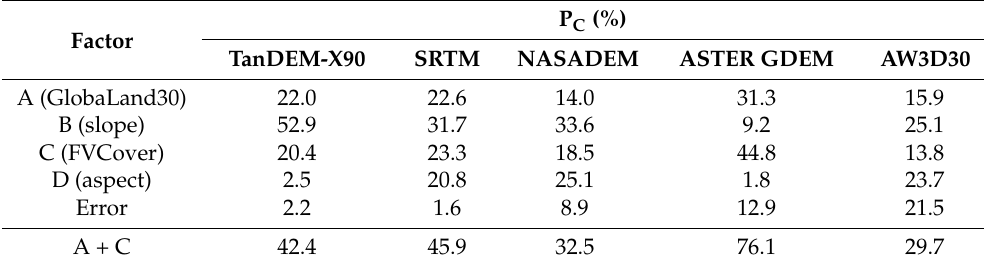
Table 7. The contribution to the DEM quality index MAE of each factor in the flat area. (The parameters are the same as in Table 3 except for the slope. The slope is separated to 0–3 ◦ /3–6 ◦ /6–8 ◦ /8–10 ◦ ).